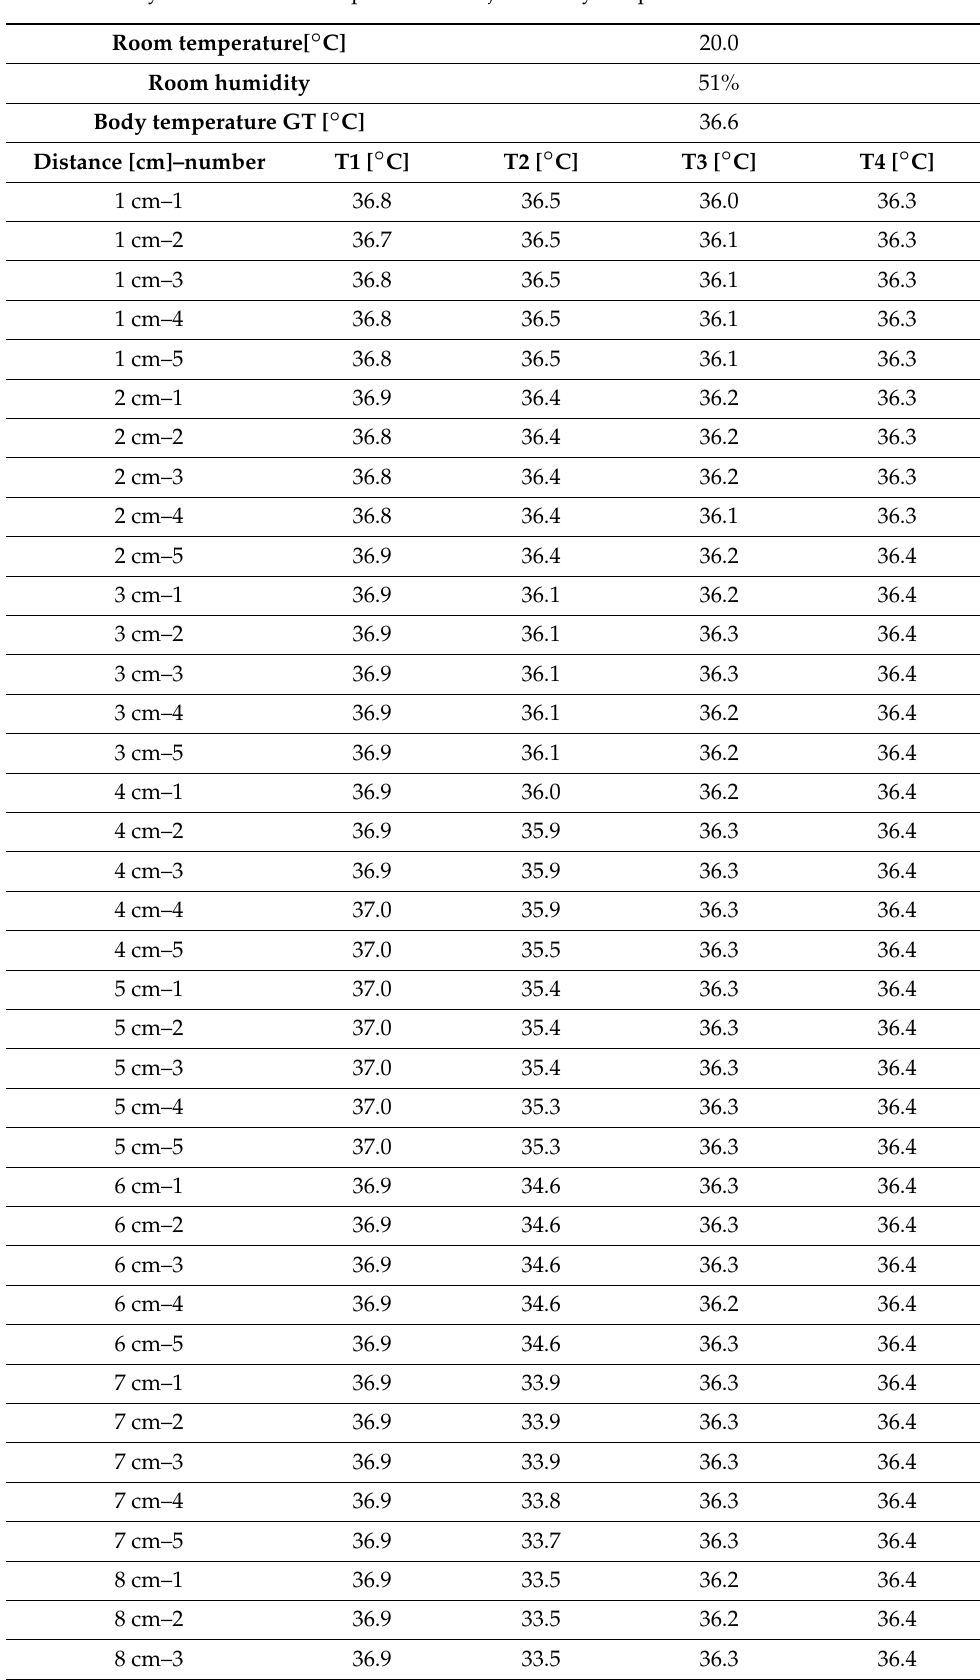
Table A6. Body–device distance experiment. Subject 3 body temperature